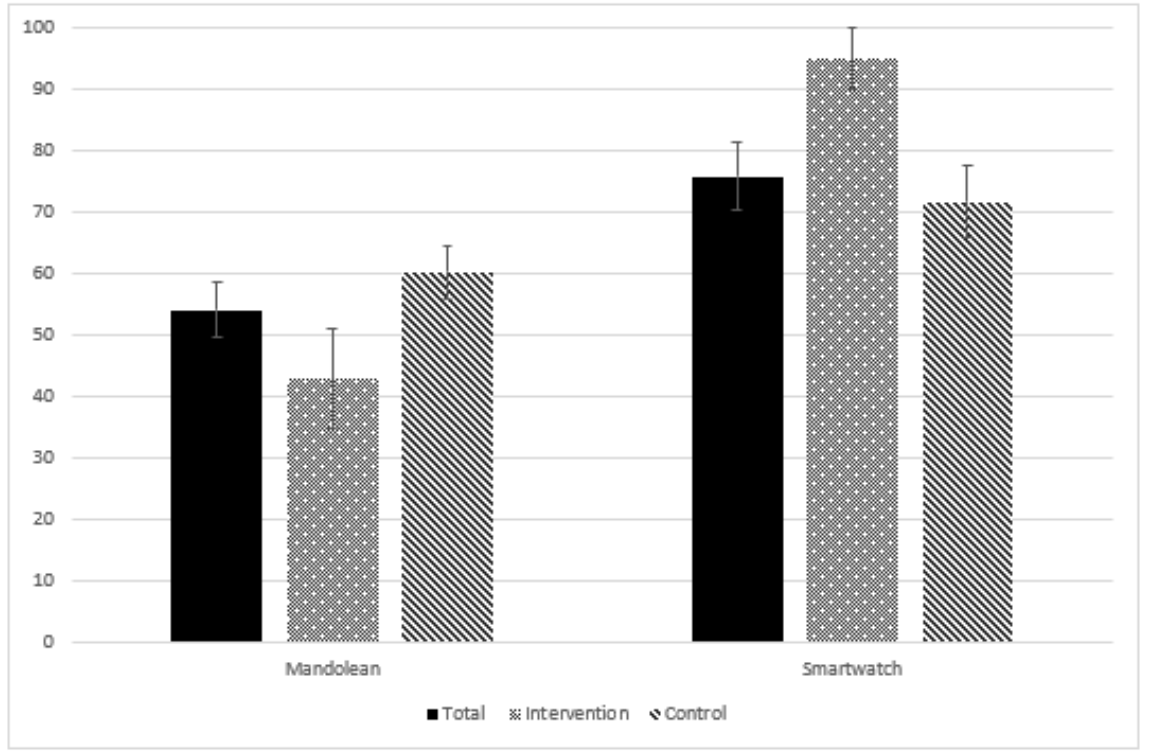
Figure 3. Bar chart showing participants’postintervention System Usability Scale scores for Mandolean and smartwatch for the total (n=11), intervention (n=4), and control (n=7)